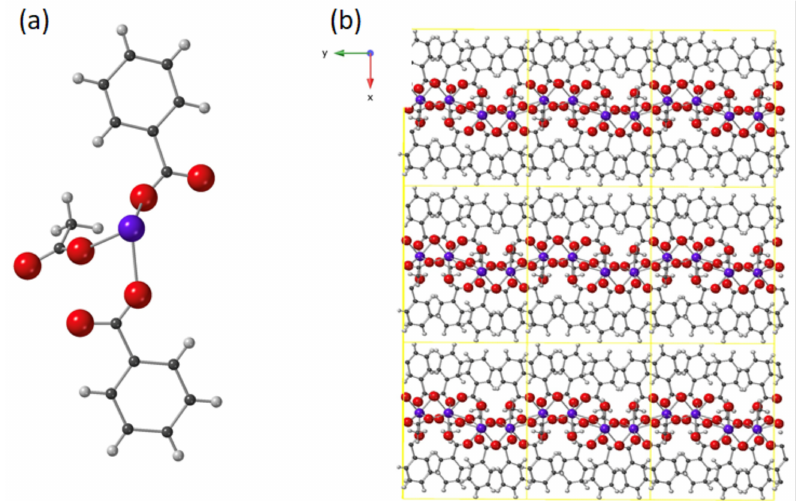
Figure 1. ( a ) Asymmetric unit of 1 , [Tb(MeCOO)(PhCOO) 2 ], and ( b ) crystal packing showing three Van der Waals stacked layers of 1 . Unit cell shown in yellow. Tb: purple; Oxygen: red; Carbon: dark grey; H: light